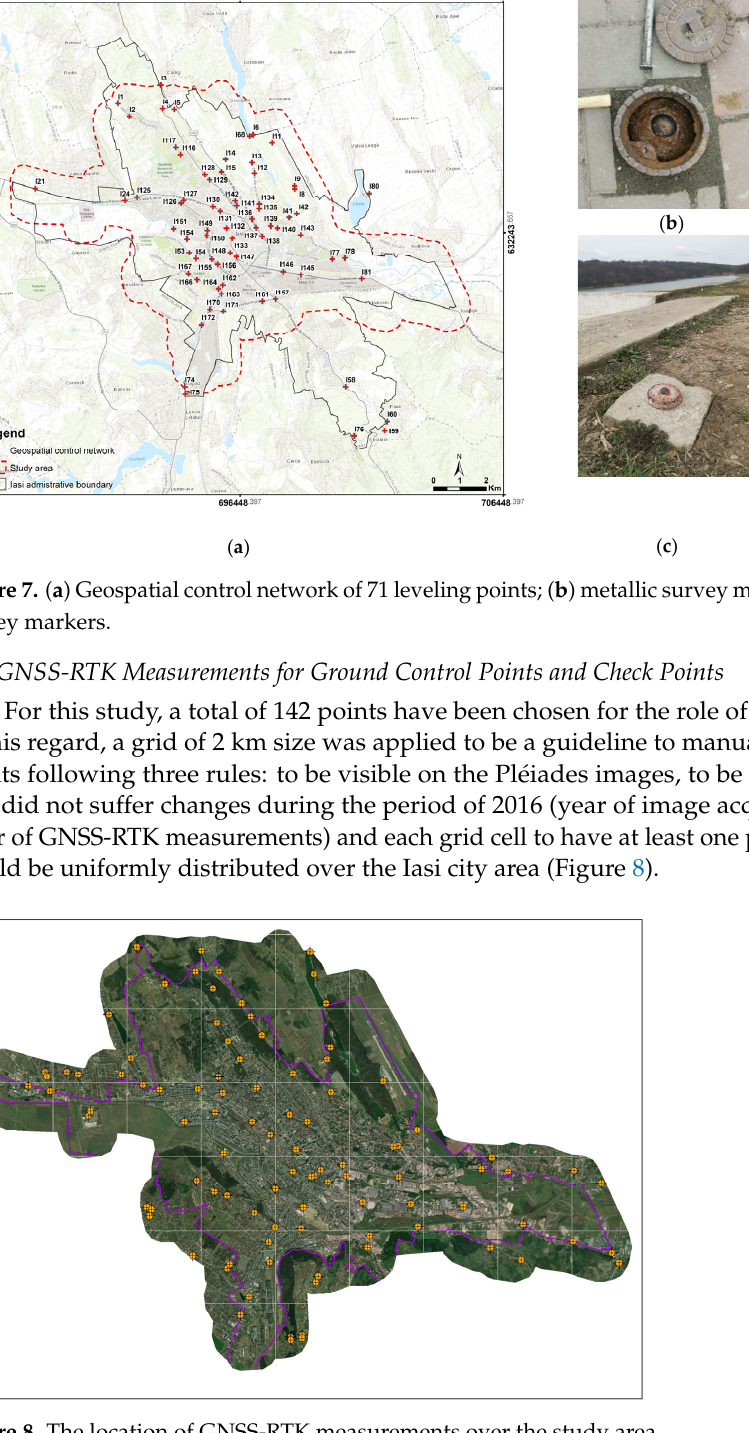
Figure 9. The location of GNSS-RTK measurements in the field and on images: ( a ) road intersection; ( b ) crosswalk and ( c ) parking markings. ( a )